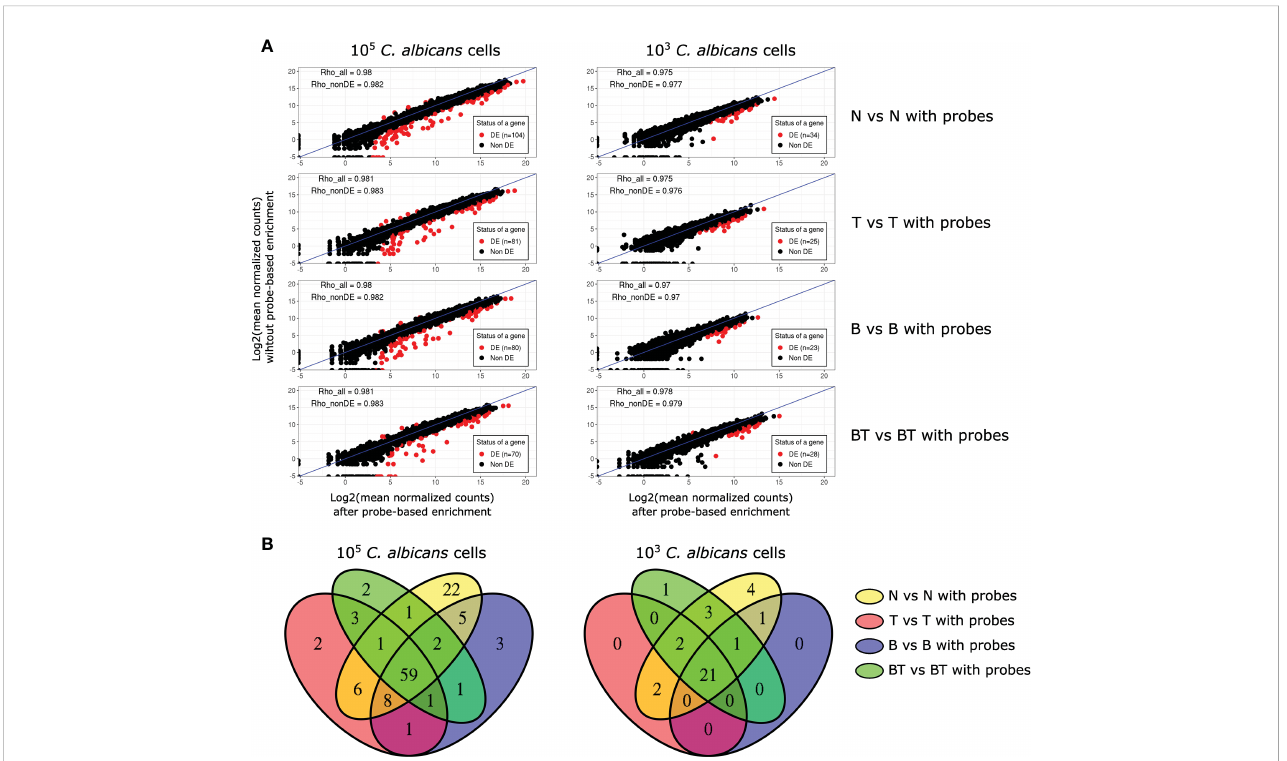
FIGURE 3 Analysis of the effect of probe-based enrichment on the expression levels of C . albicans genes across all experimental conditions. (A) Correlation plots of average normalized fungal read counts between original (y-axis) and probe-enriched (x-axis) samples. DE - Differentially Expressed; Rho_all - Spearman ’ s correlation coef fi cients calculated with all genes; Rho_nonDE: Spearman ’ s correlation coef fi cients calculated with all genes, excluding differentially expressed ones; (B) Venn diagrams of DE genes between non-probe-enriched and probe-enriched